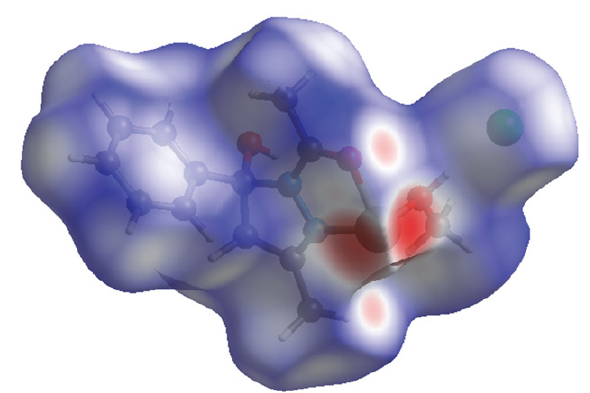
Fig. 3. Hirshfeld surface mapped with d norm for complex 1